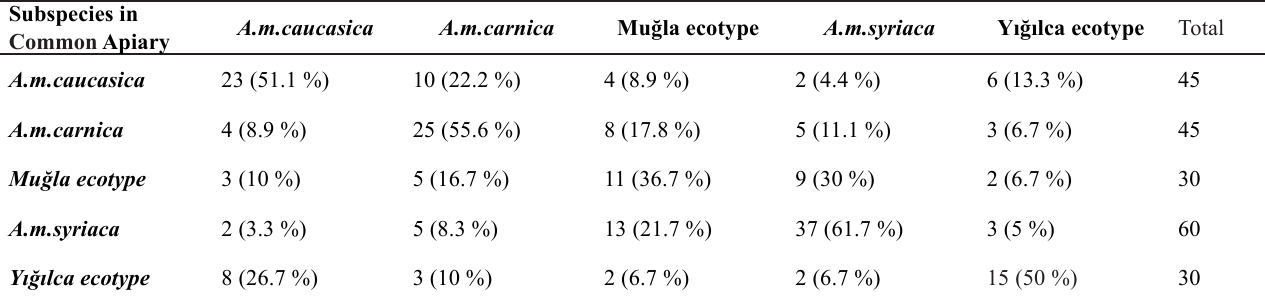
Table 3 . Predicted group membership of honeybee colonies from common apiary covered all honeybee races of Turkey.